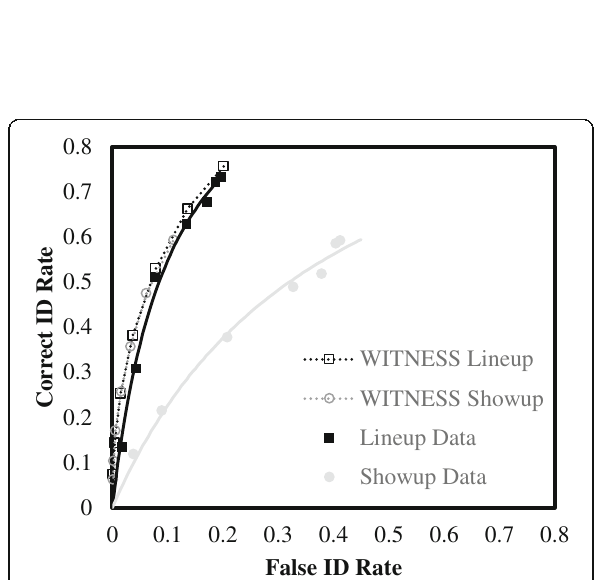
Fig. 5 Empirical data from Wetmore et al. (2015) data and best fit to the data by the WITNESS model. Best-fitting parameters were: a = .31, SSF = .35, SSP = .50, csim = .07, csu = .095. SSP Similarity of the innocent Suspect to the PERP, SSF Similarity of the Suspect to the Fillers, PERP perpetrator